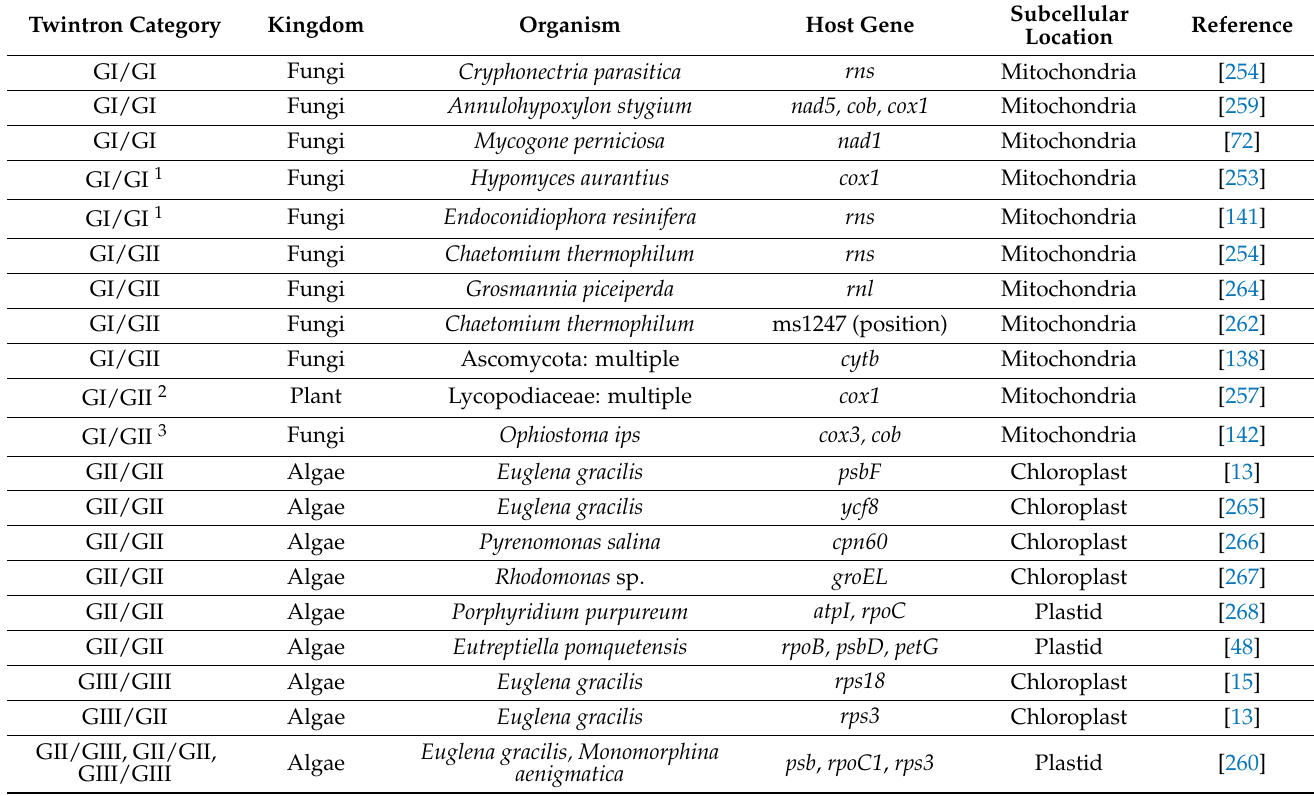
Table 1. Examples of complex introns composed of self-splicing organellar intron modules across the three kingdoms: plant, algae, and fungi. Twintron